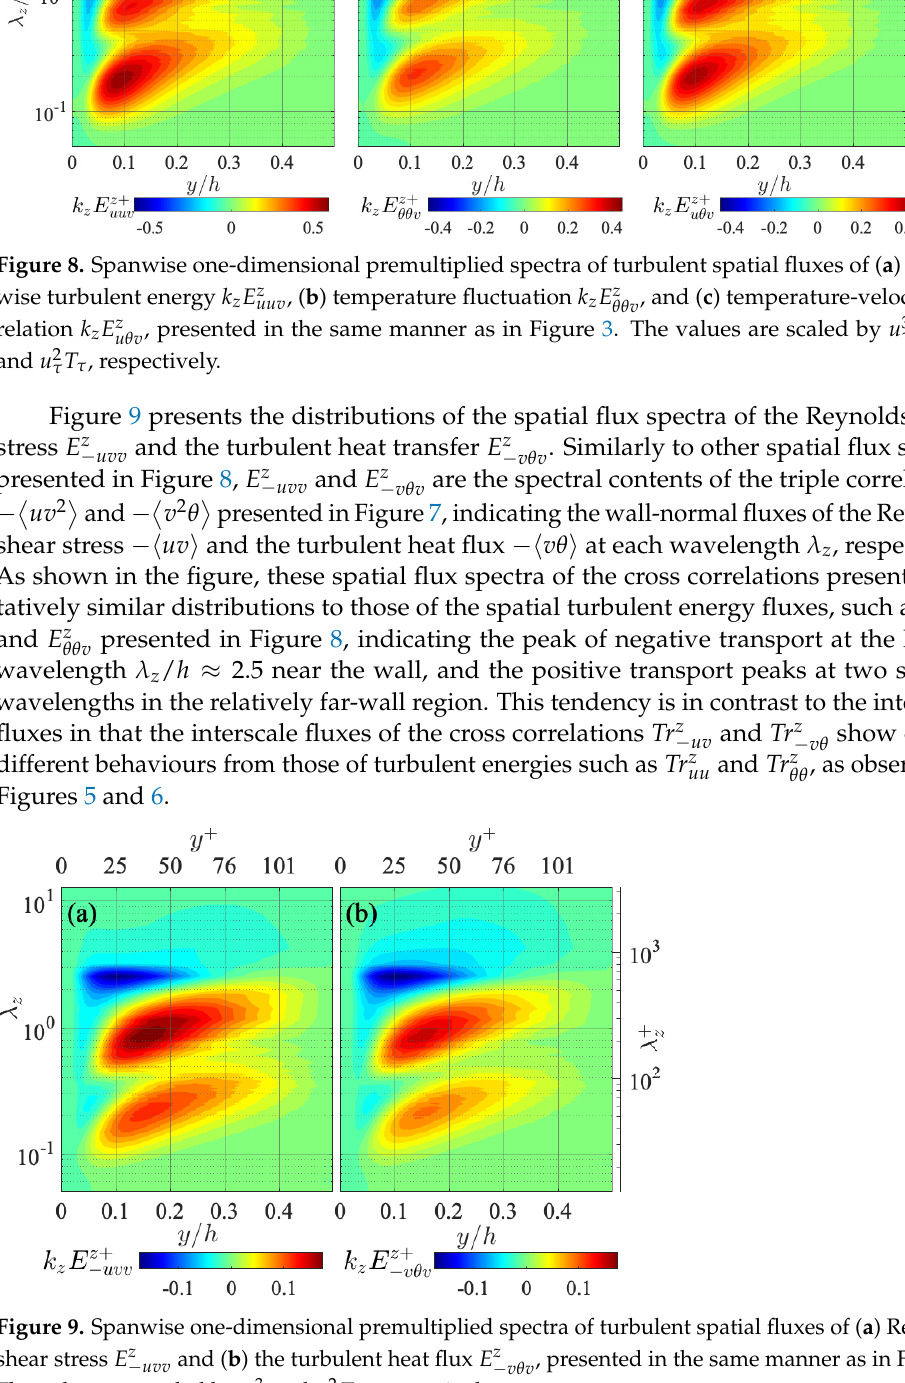
, presented in the same manner as in Figure 3. v θ v